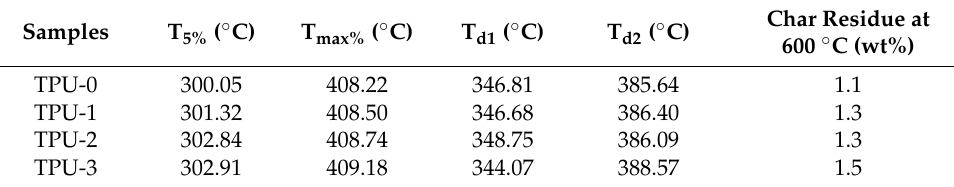
Figure 3. ( a ) TGA and ( b ) DTA thermograms of synthesized TPU samples. Table 4. TGA characterization studies of the synthesized TPU Table 4. TGA characterization studies of the synthesized TPU samples.